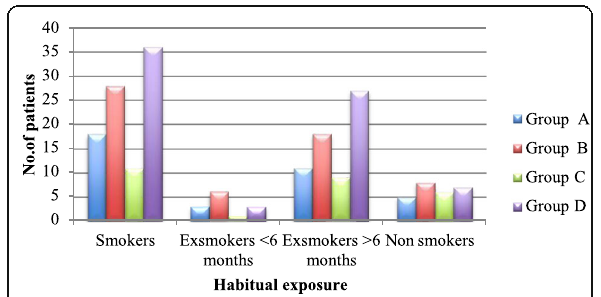
Fig. 10 Distribution of habitual exposure with severity